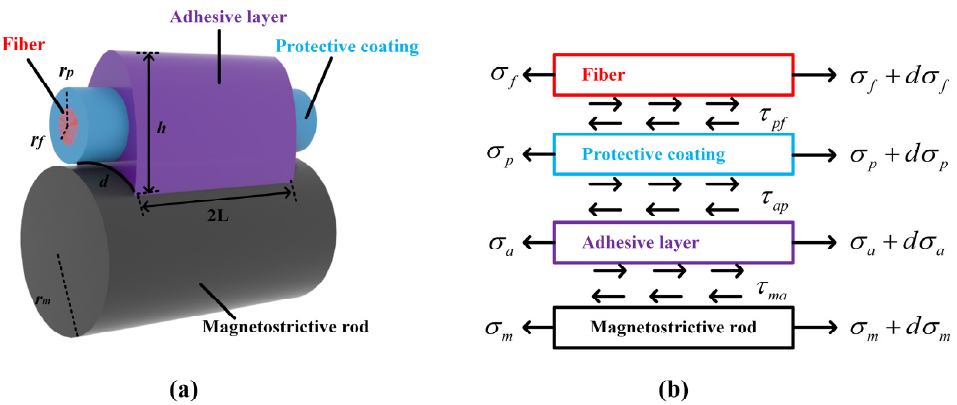
Figure 1. ( a ) Schematic diagram of the 3D four-layer model structure; ( b ) free-body diagrams of the sensor configuration stress distribution.